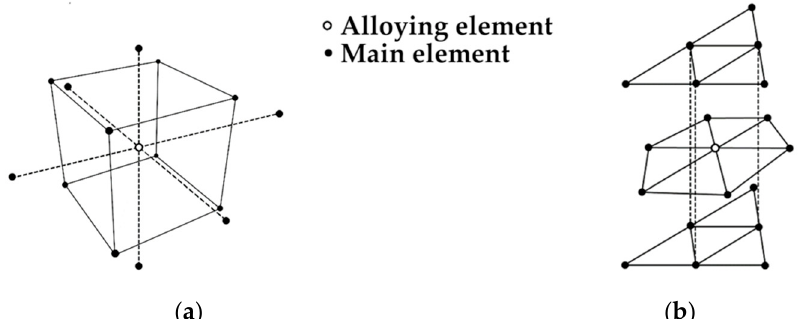
Figure 2. Placement of the main and alloying element atoms in body-centered cubic lattice ( a ) and hexagonal close-packed lattice ( b ).